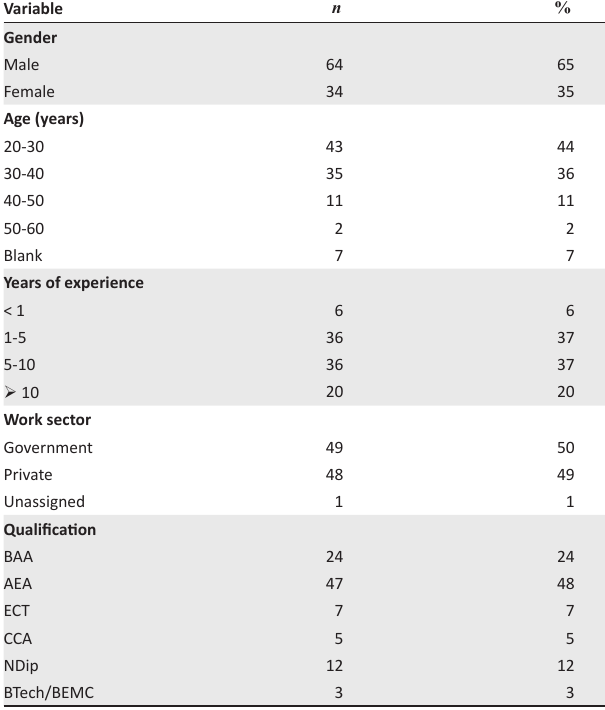
TABLE 1: Sample description ( n =